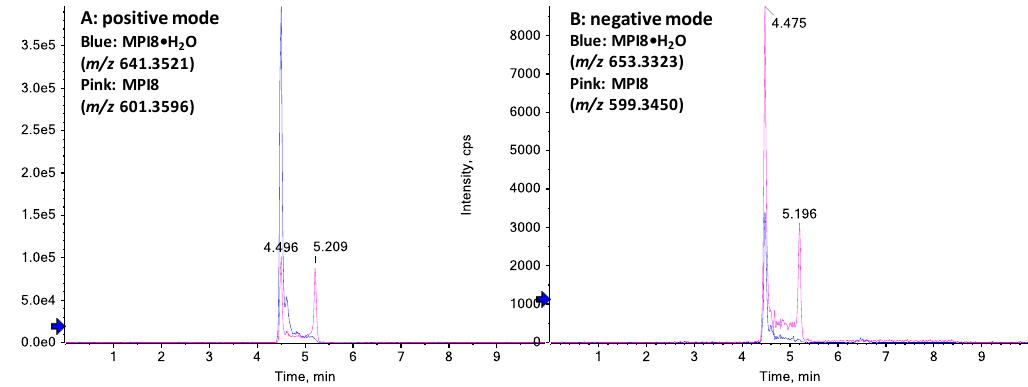
Figure 4. HR-MS extracted ion chromatograms of MPI8 and MPI8•H 2 O eluted on a Synergi Fusion- RP column; the peak at 5.2 min was MPI8; the peak at 4.5 min was MPI8•H 2 O, and the MPI8 signal was due to the in-source fragmentation: ( A ) MPI8 ([MPI8 + H] + ) m/z 601.3596 in pink and MPI8•H 2 O ([MPI8•H 2 O + Na] + ) m/z 641.3521 in blue in positive mode ( B ) MPI8 ([MPI8 − H] − ) m/z 599.3450 in pink and MPI8•H 2 O ([MPI8•H 2 O + Cl] − ) m/z 653.3323 in blue in negative mode.